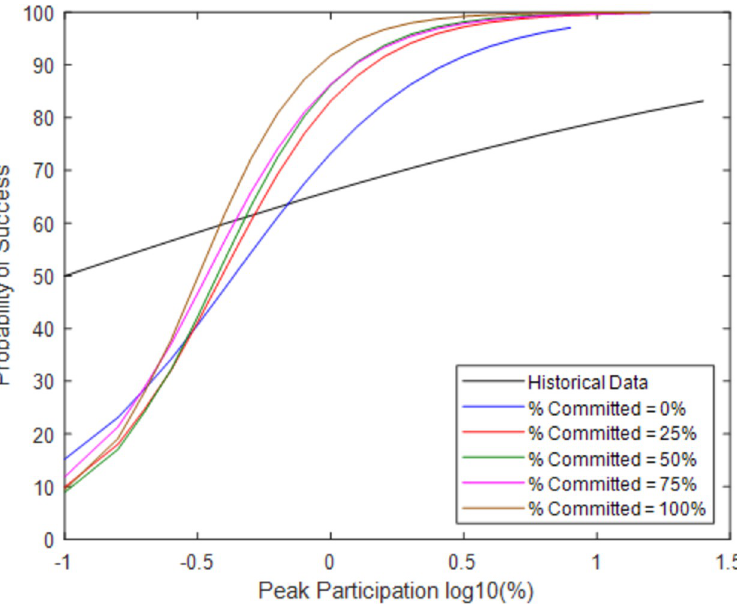
Fig 5. Probability of success at a given peak participation with varying percent